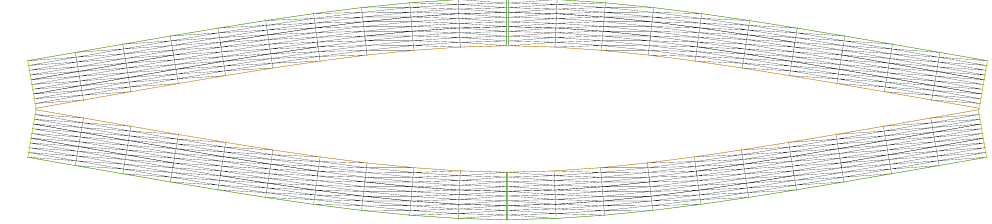
Figure 14. Incision retraction simulation with FreeFeem++